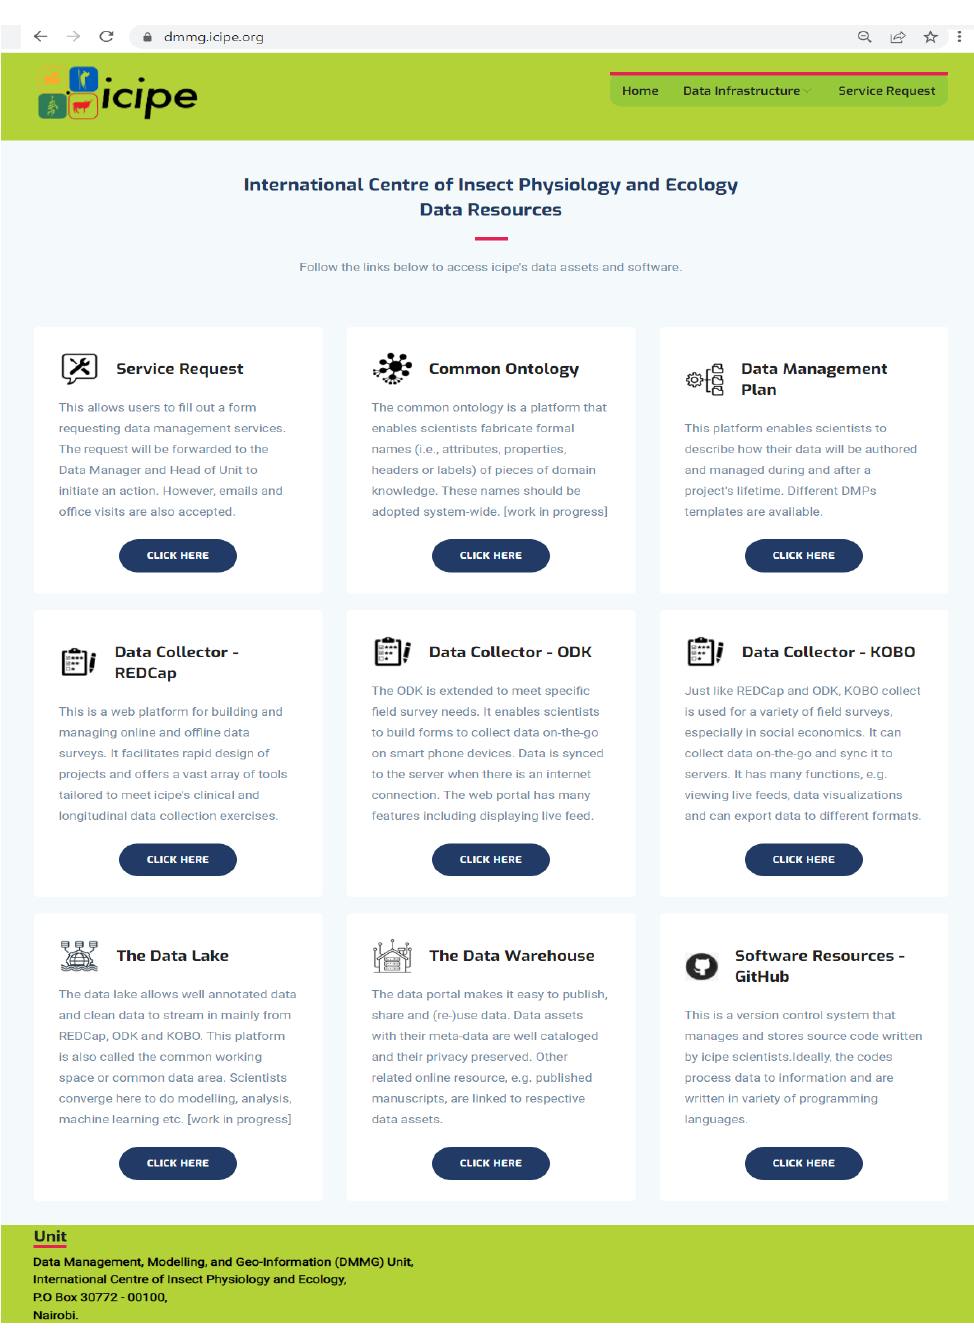
Figure 3. The landing web page to icipe’s research data management and archiving infrastructure, the